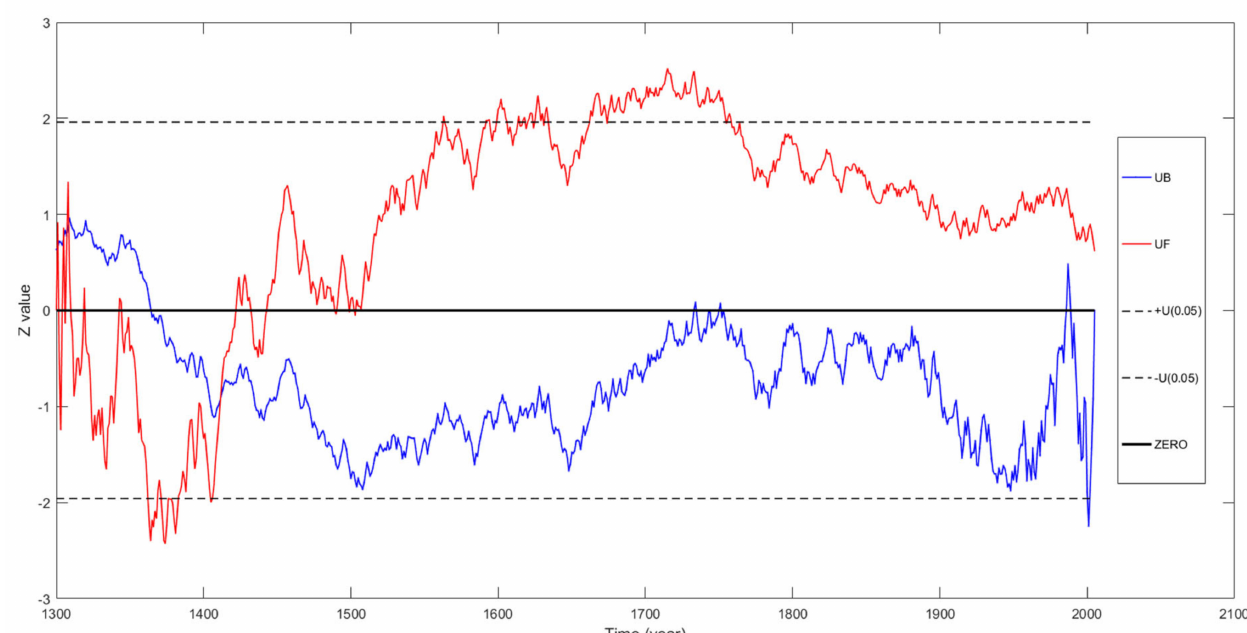
Figure 2. The result of the MK test of the PDSI series from 1300 to 2005. UF represents the statistics of forward sequence, UB the statistics of backward sequence. ± U (0.05) is the significance level α =